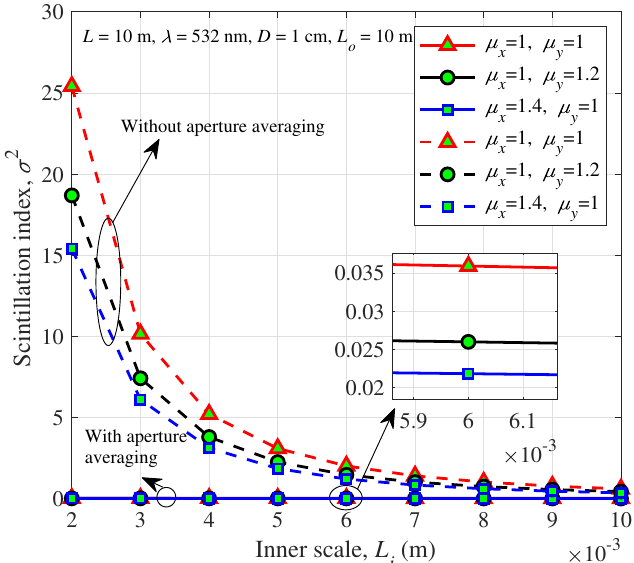
Figure 8. Scintillation index of a spherical wave versus the inner scale with and without the aperture averaging effect for different anisotropic